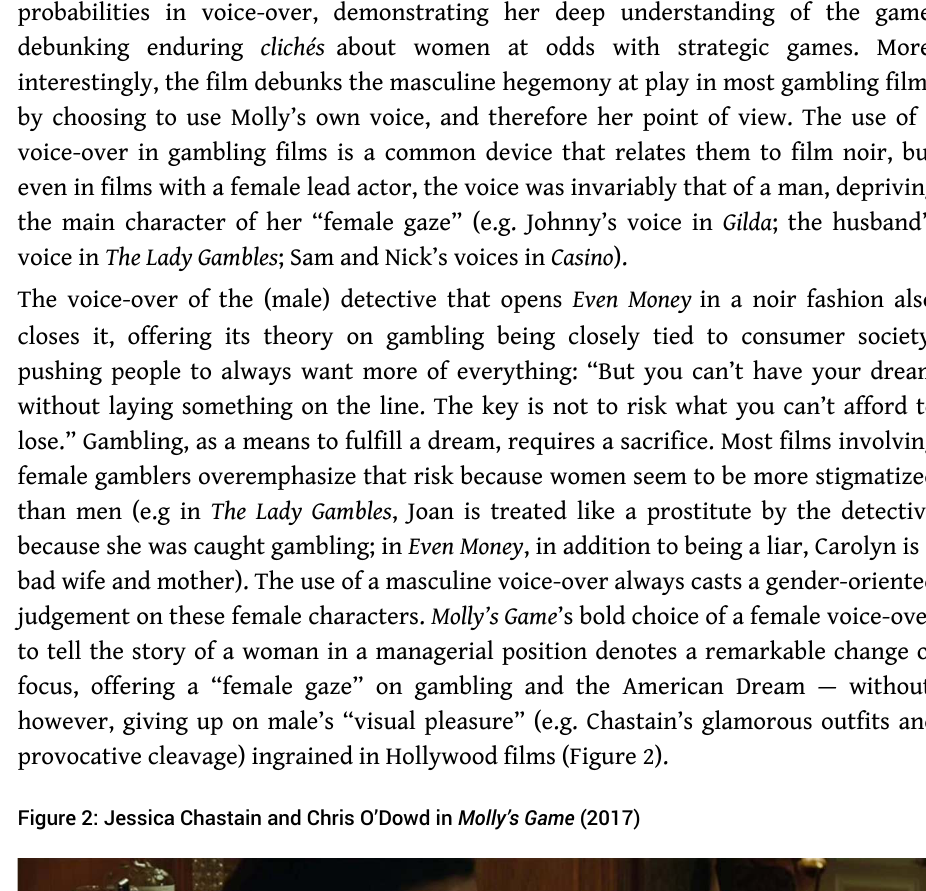
Figure 2: Jessica Chastain and Chris O’Dowd in Molly’s Game (2017)